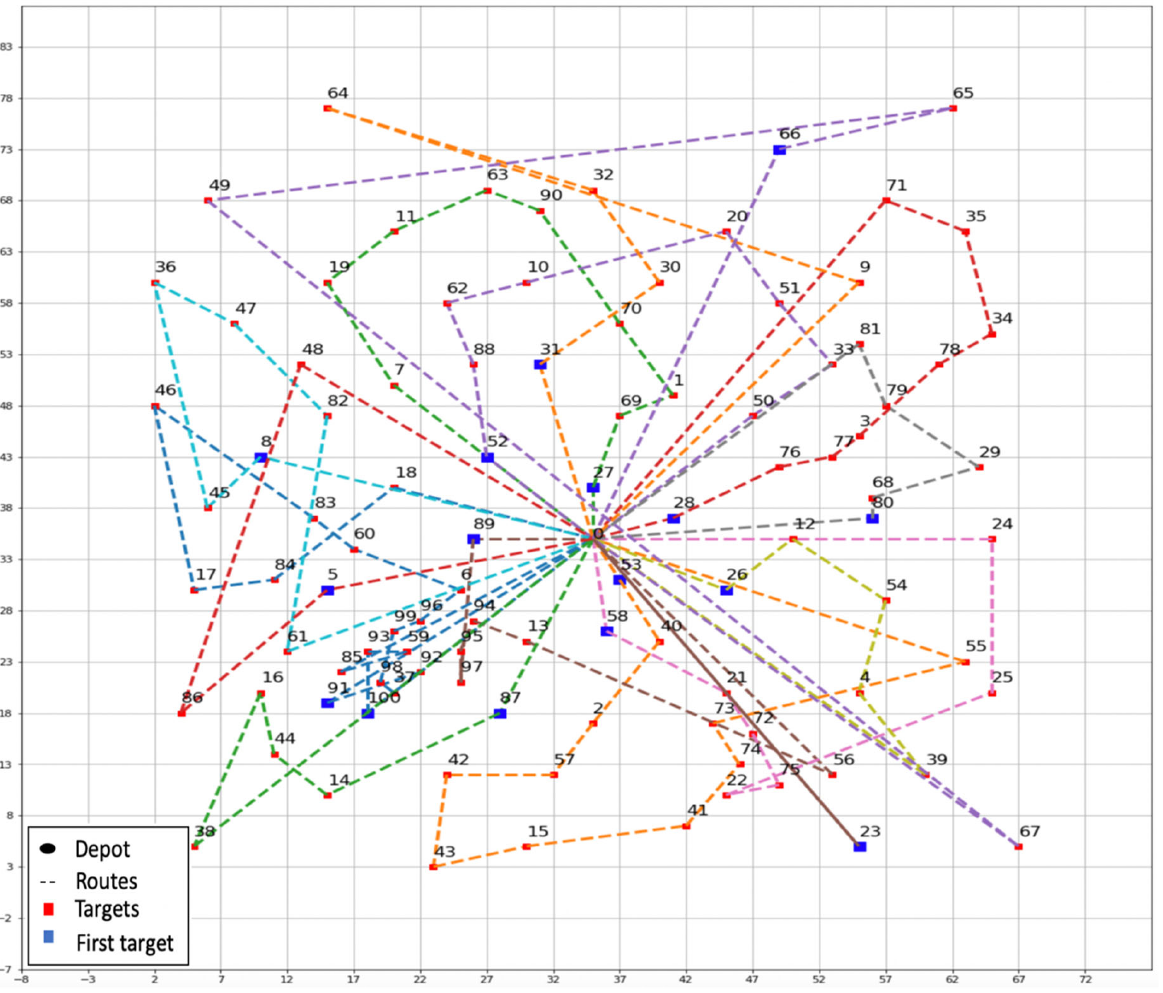
Figure 6. Initial solution of the GBDOH for instance E ‐ n101 ‐ k14.